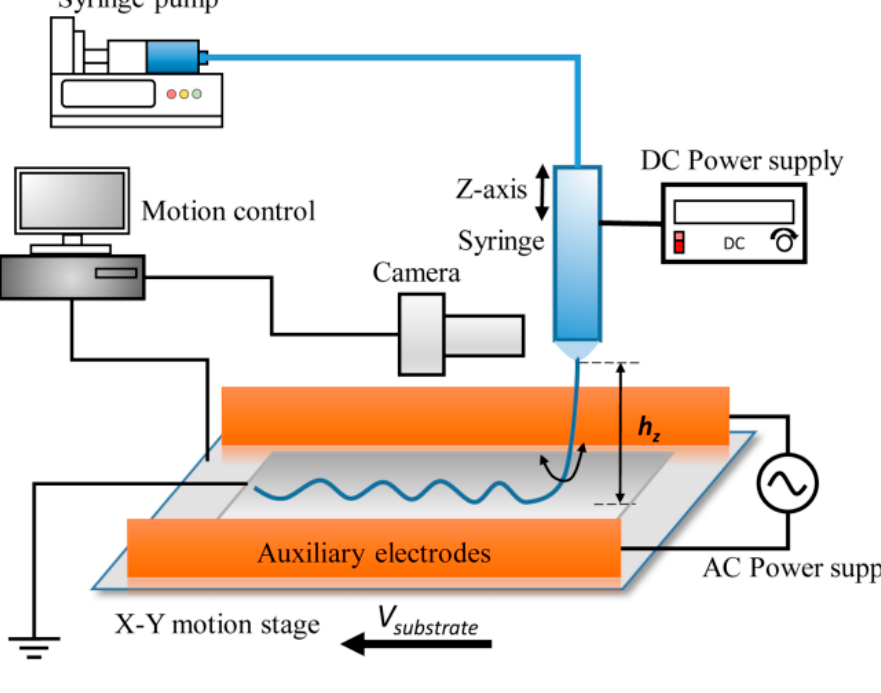
Figure 1. Schematic diagram of wavy-direct-writing.